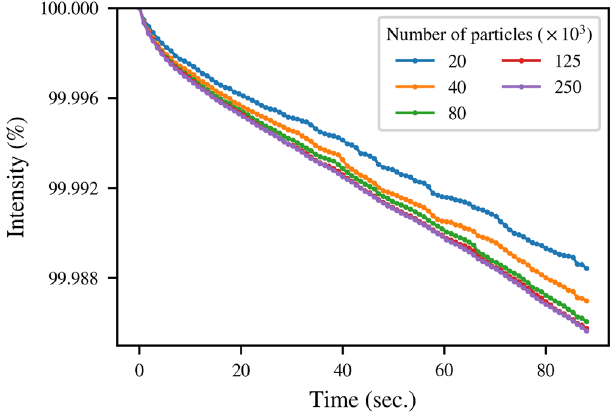
FIG. 13. Intensity evolution computed with 20 × 10 3 (blue), 40 × 10 3 (orange), 80 × 10 3 (green), 125 × 10 3 (red), and 250 × 10 3 (purple) particles and the weights from Eq.